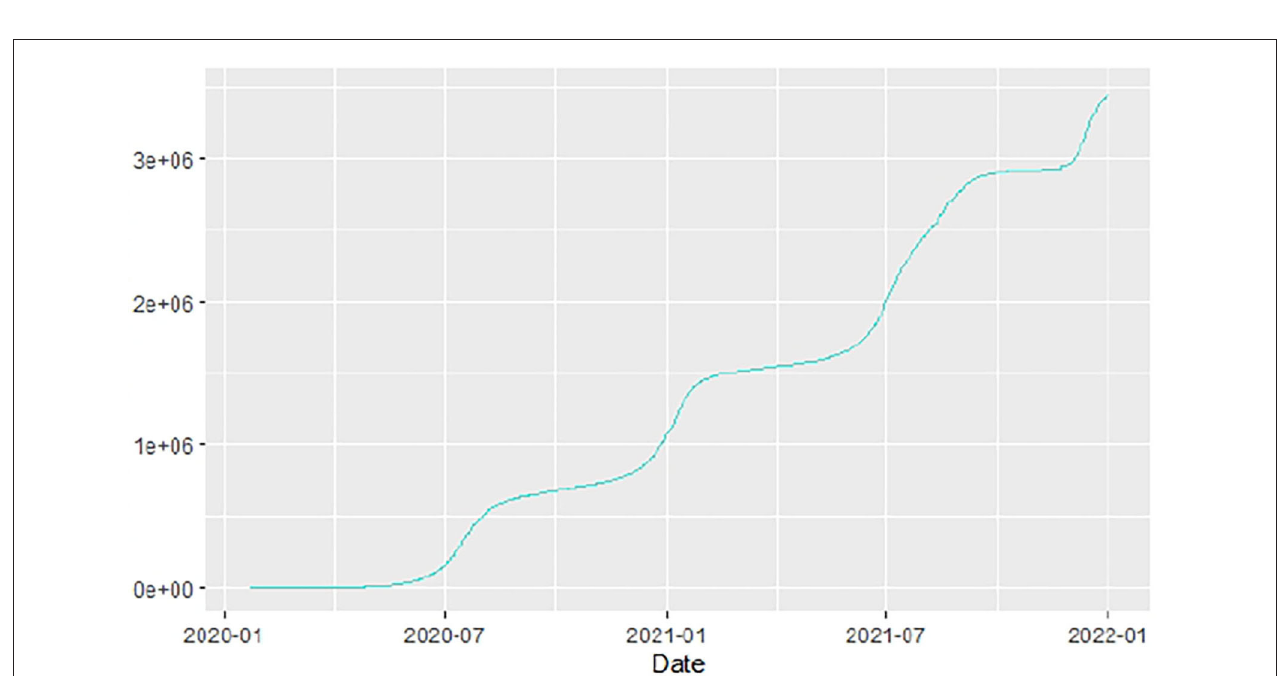
FIGURE 8 | South Africa cases.